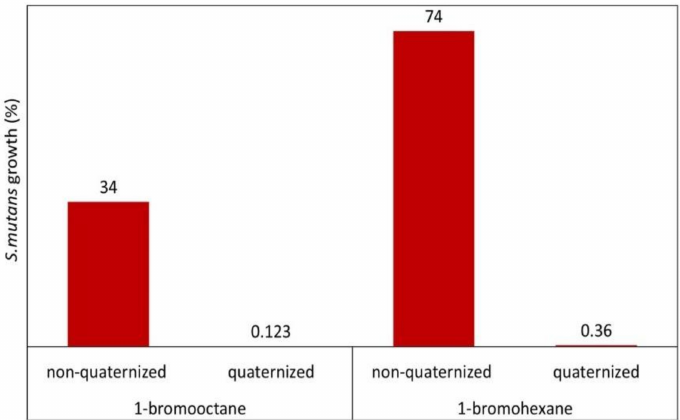
Figure 10. S. mutans growth (%) on the surface of a restorative composite resin containing 1 wt.% quaternized and non-quaternized QA-PEI nanoparticles. Data from